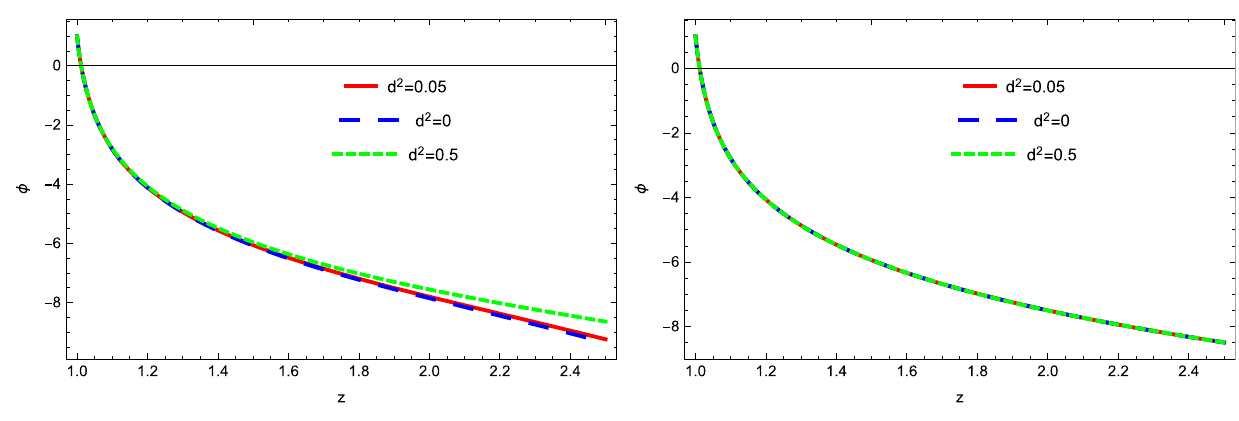
Fig. 44 Plot of φ verses z for u = 1 and u = 2 . 002 for dilaton scalar field